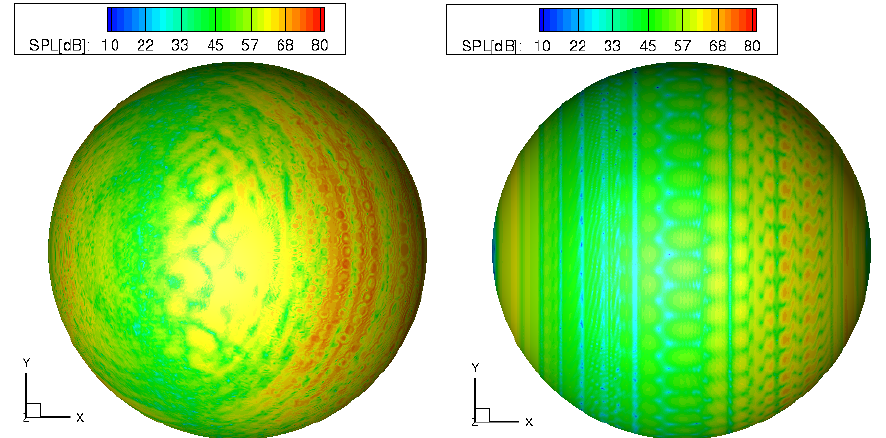
Figure 15. Scattered noise (BEM, left ) results for frequency 2000 Hz, Clean case, compared to Direct noise field ( right ).